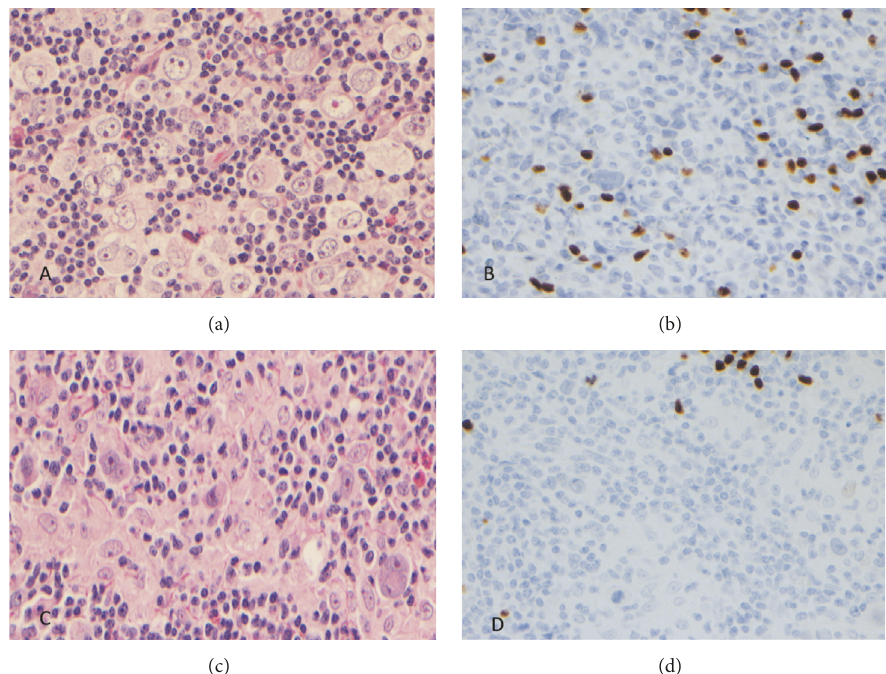
Figure 1: (a and c) Large atypical lymphoid cells with one to more nuclei, prominent nucleoli, and abundant cytoplasm consistent with RS cells and Hodgkin cells on the hematoxylin and eosin stain. (b and d) The large atypical cells are negative for PAX5 expression.